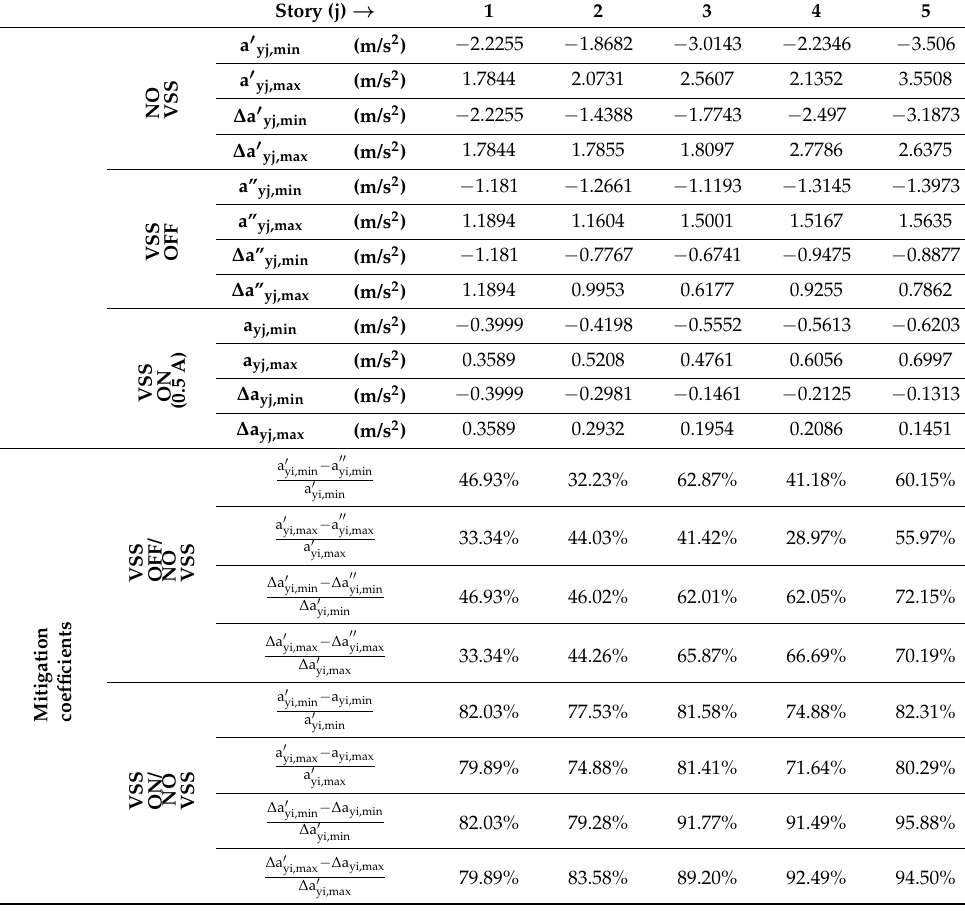
Table 6. Seismic response of the reference structure, peak values of the relevant parameters, and mitigation coefficients (experimental data).